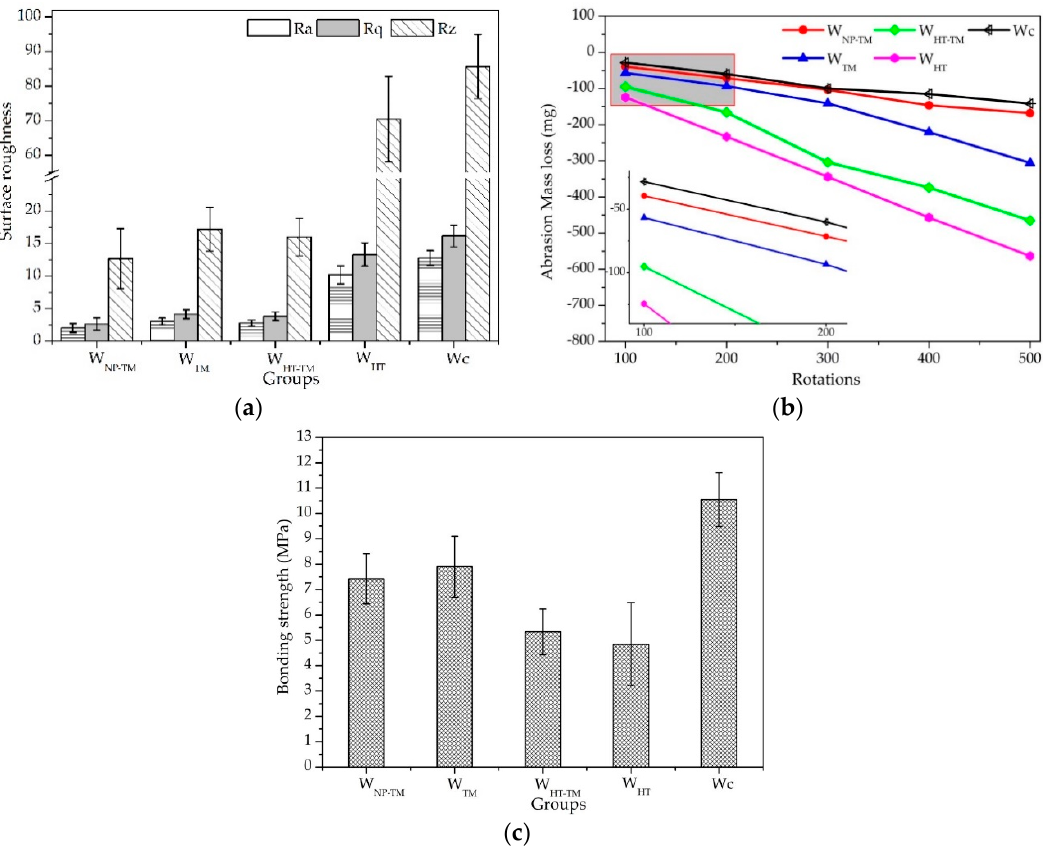
Figure 3. The surface roughness ( a ), abrasion mass loss ( b ), and bonding strength ( c ) of untreated and treated poplar.